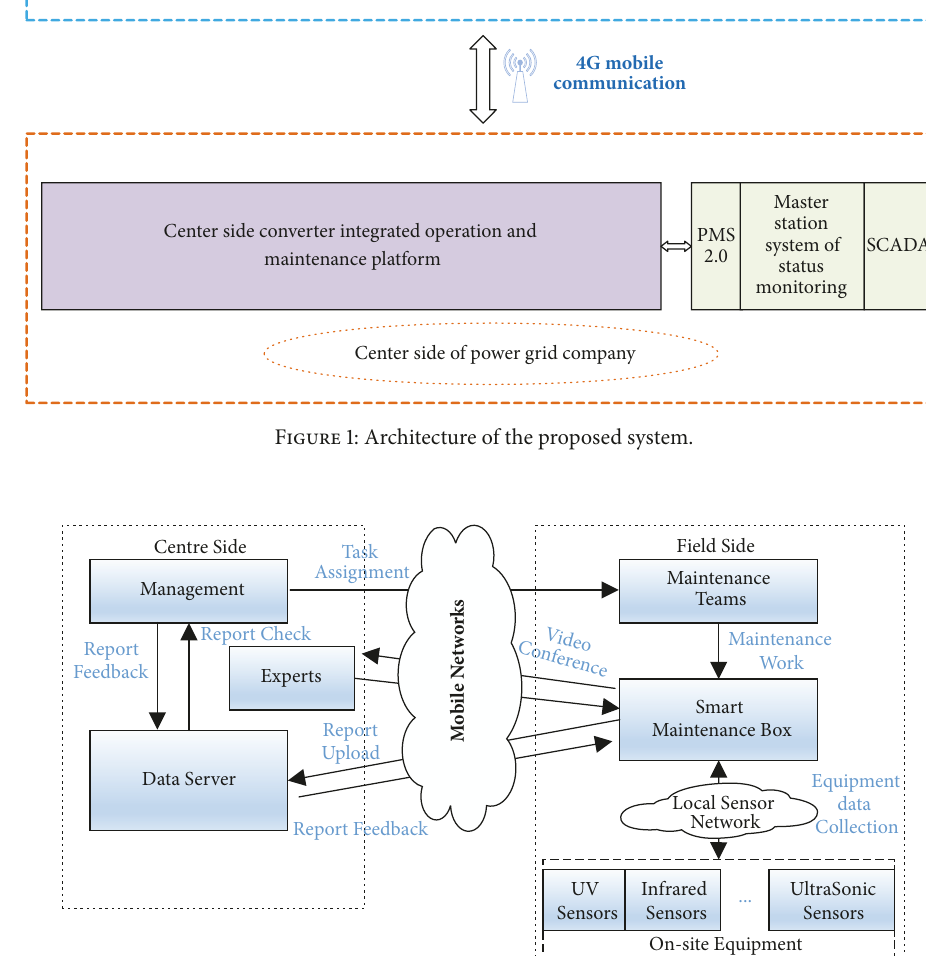
Figure 2: Structure of networked closed-loop smart maintenance